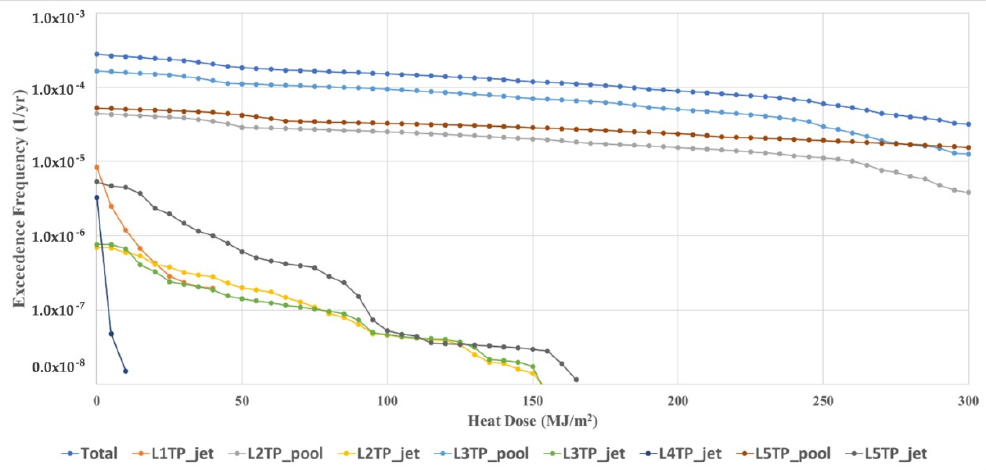
Figure 17. Fire exceedance frequency curves on PR1_1st